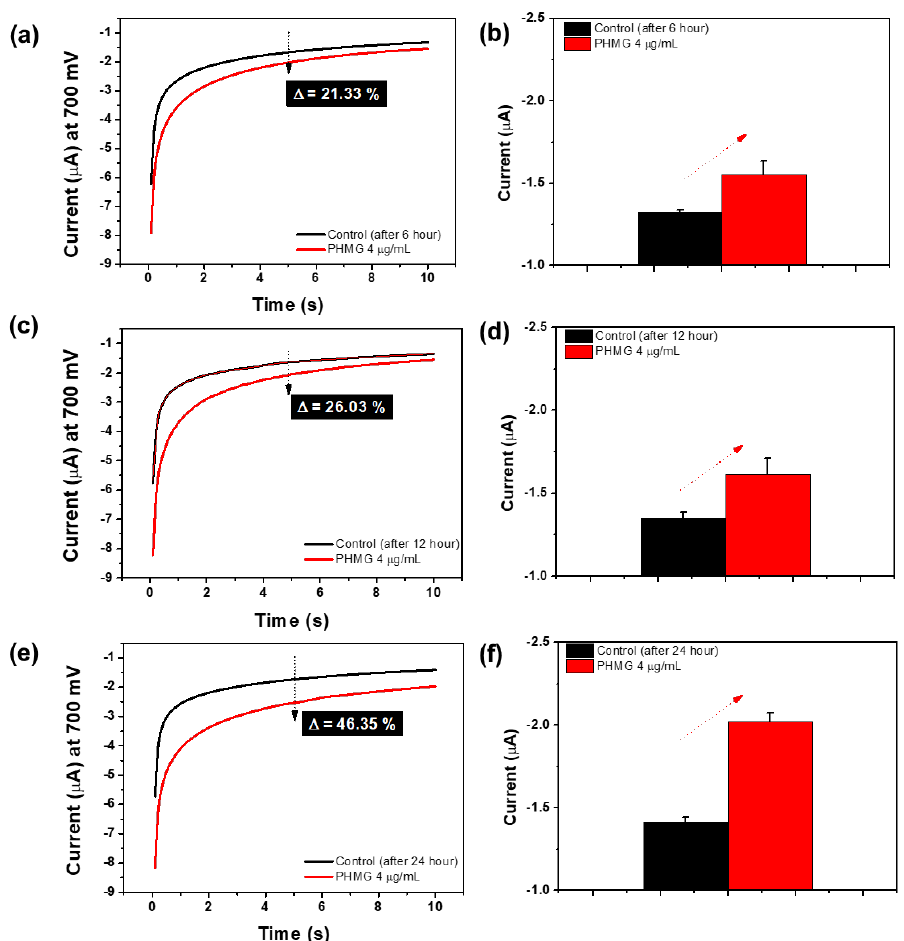
Figure 4. Chronoamperometry measurement of PHMG-induced cells for cell viability monitoring: ( a , b ) control vs. 6 h; ( b , c ) control vs. 12 h; ( d , e ) control vs. 24 h after exposure (n = 5).